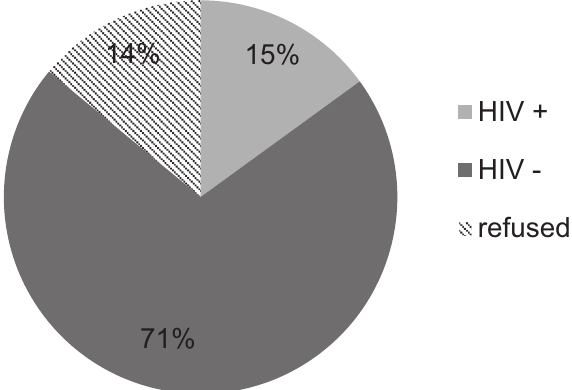
Figure 2. Total hip arthroplasty population voluntary counselling and testing results.